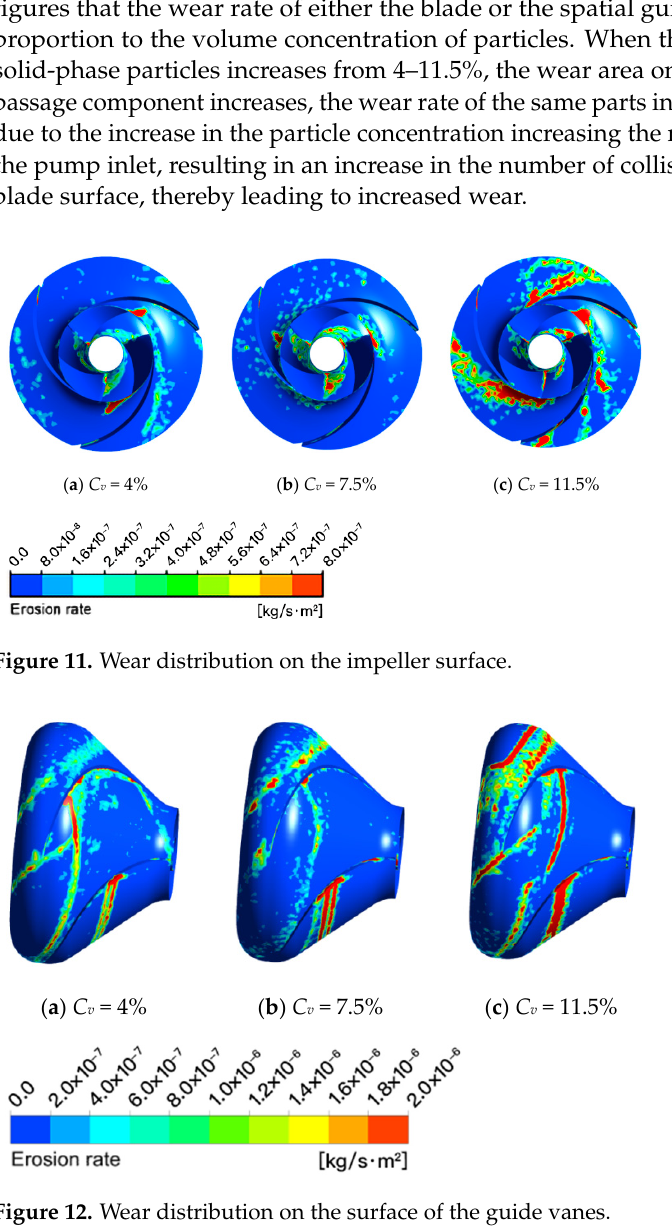
Figure 12. Wear distribution on the surface of the guide vanes.